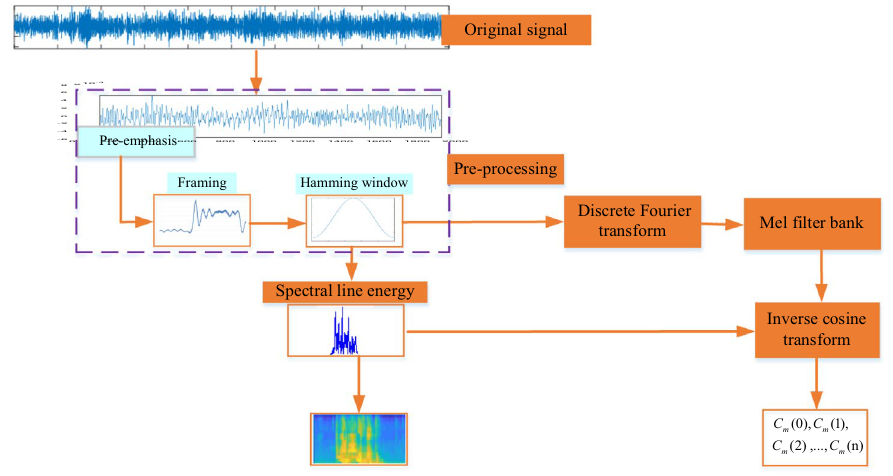
Figure 1. Schematic of MFCC feature extraction.